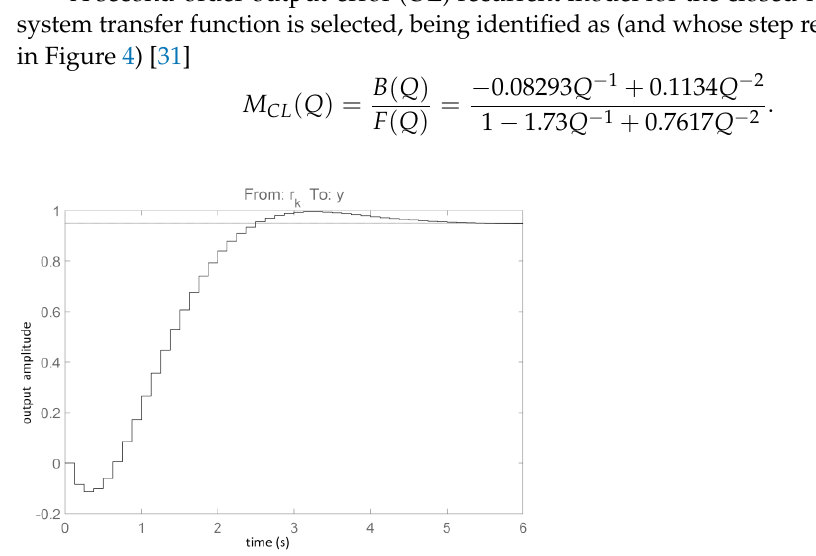
Figure 6. Unit reference input step response of the closed-loop with 2DOF controller, vs. the ORM unit step response.